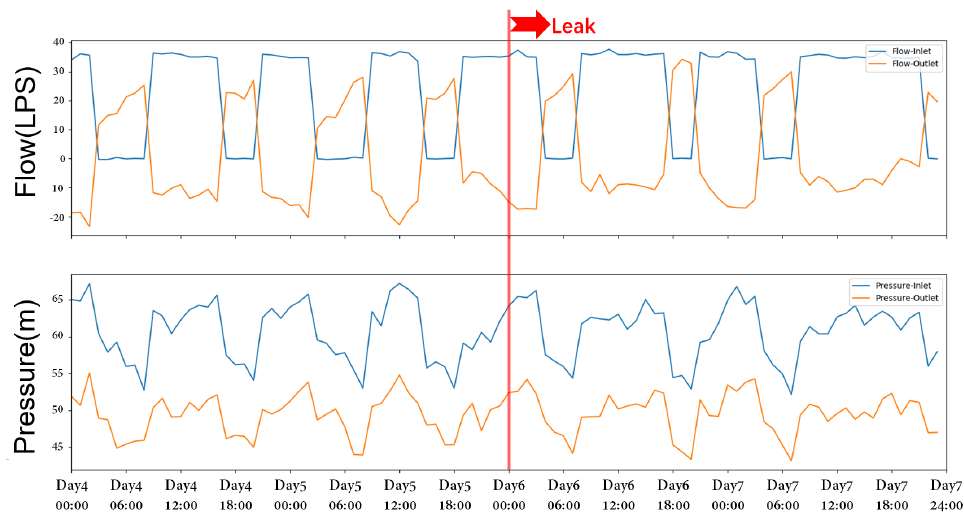
Figure 7. Change curve of hydraulic parameters before and after leakage.